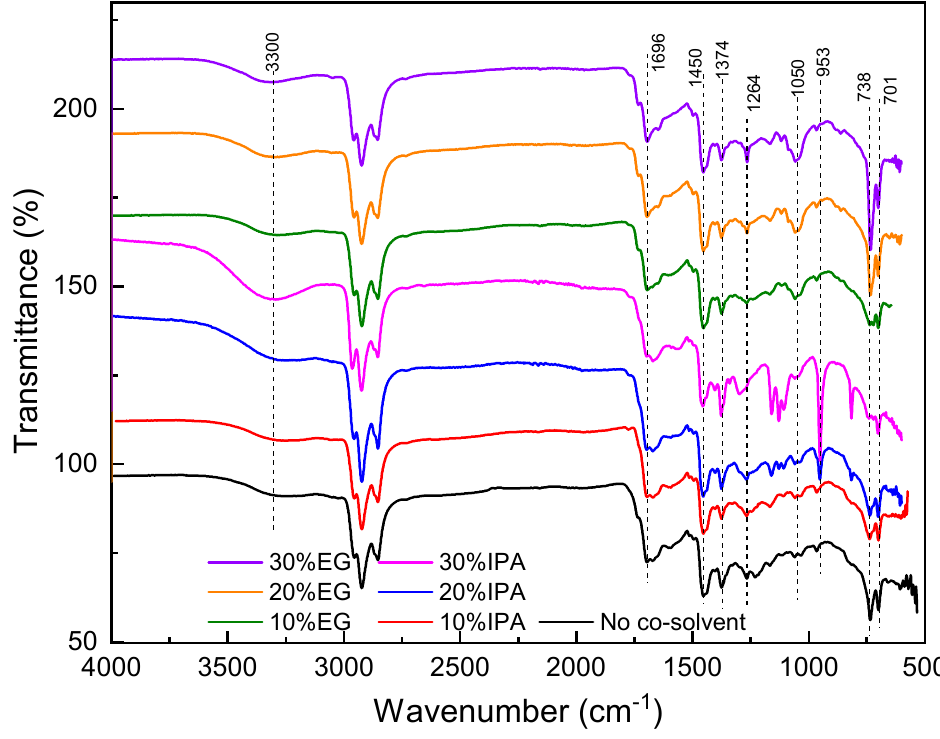
Figure 9. FTIR spectra of biocrude products from HTL of Tetraselmis sp. at 350 °C with the inclusion of varying amounts of co-solvent. (IPA: Isopropyl alcohol; EG: Ethylene glycol).